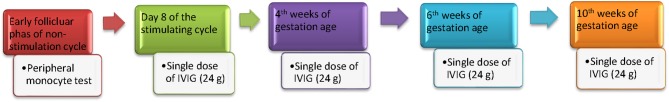
The timing and protocol of IVIG treatment. Peripheral monocyte test was performed on the 2–3rd day of the menstrual cycle prior to ovarian hyperstimulation. Women received the first dose of IVIG (24 g TBSF human immunoglobulin; CSL Limited, Broadmeadous, Australia) on day 8 of the stimulating cycle. If a viable pregnancy was confirmed by serum hCG concentrations and ultrasound, IVIG was continued in 4, 6, and 10th weeks of gestation age (a total dose of 96 g) according to the published protocol.